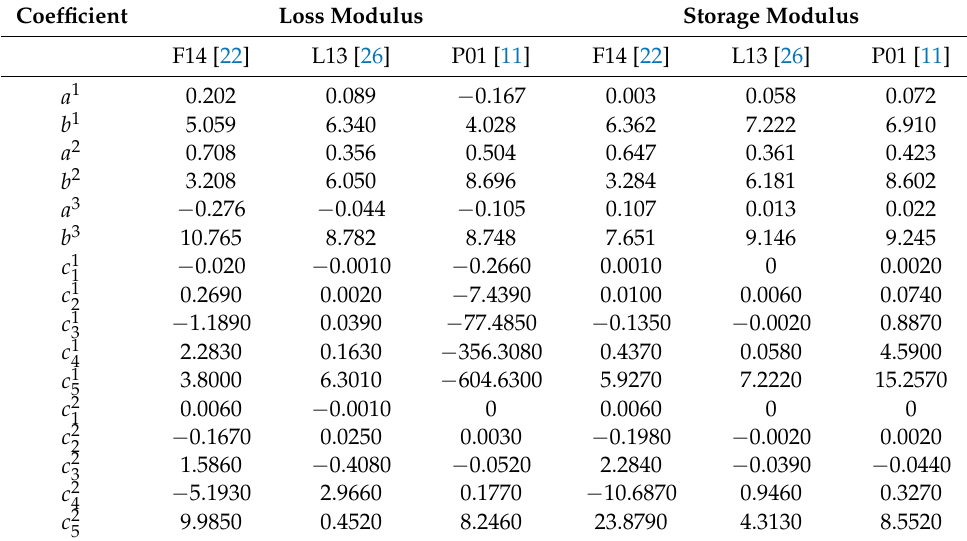
Table 1. Coefficients of polynomial fitting for the curves shown in Figure